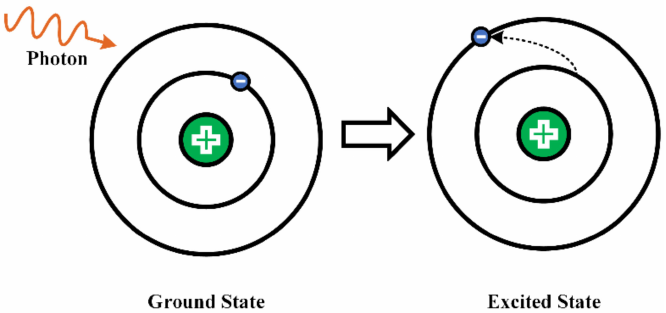
Figure 3. Schematic diagram of photon absorption by turbulent